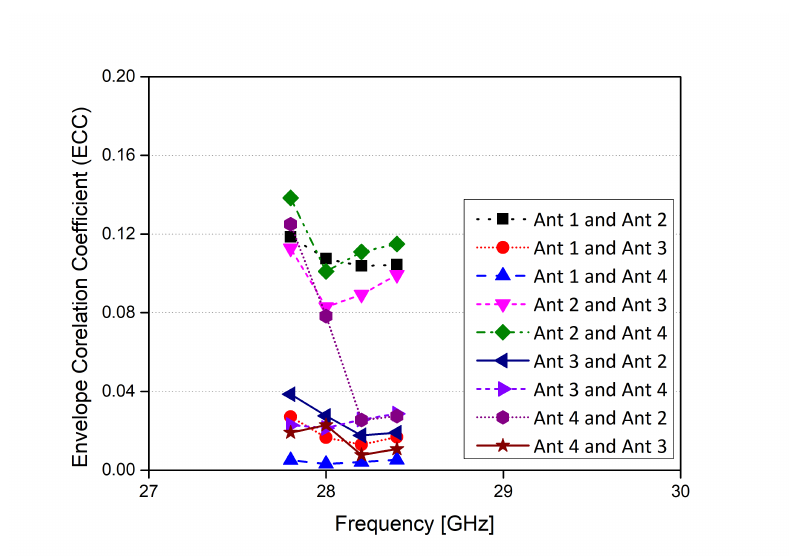
Figure 10. Envelope correlation coefficient for the MIMO antenna.